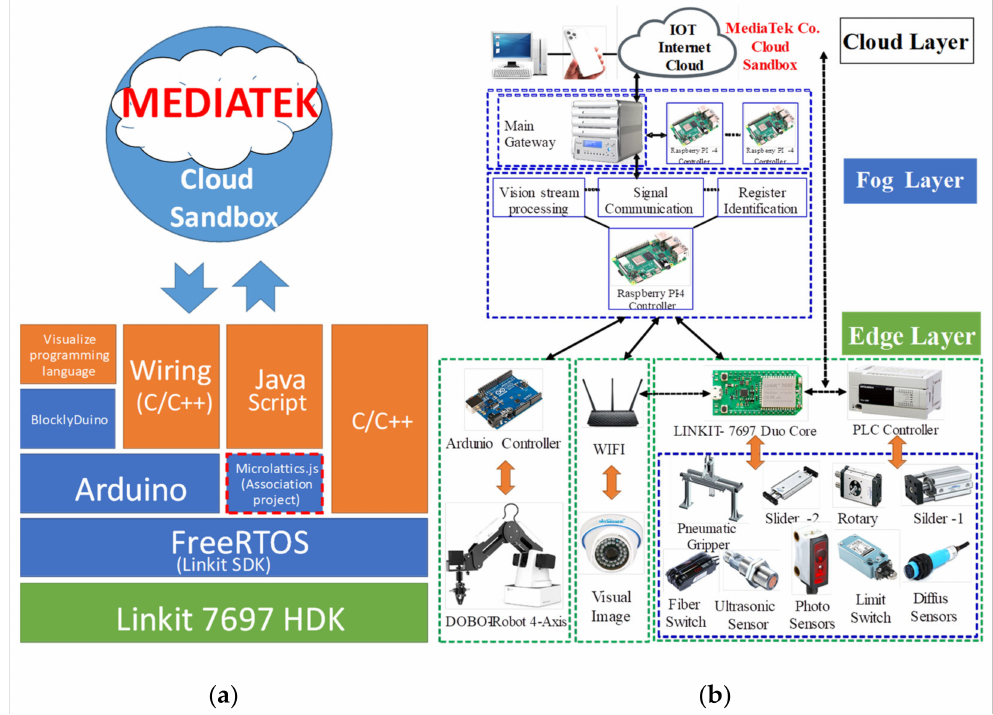
Figure 9. Low-cost IoT architecture: ( a ) Cloud computing MediaTek Linkit-7697 structure, ( b ) diagram of complete communication